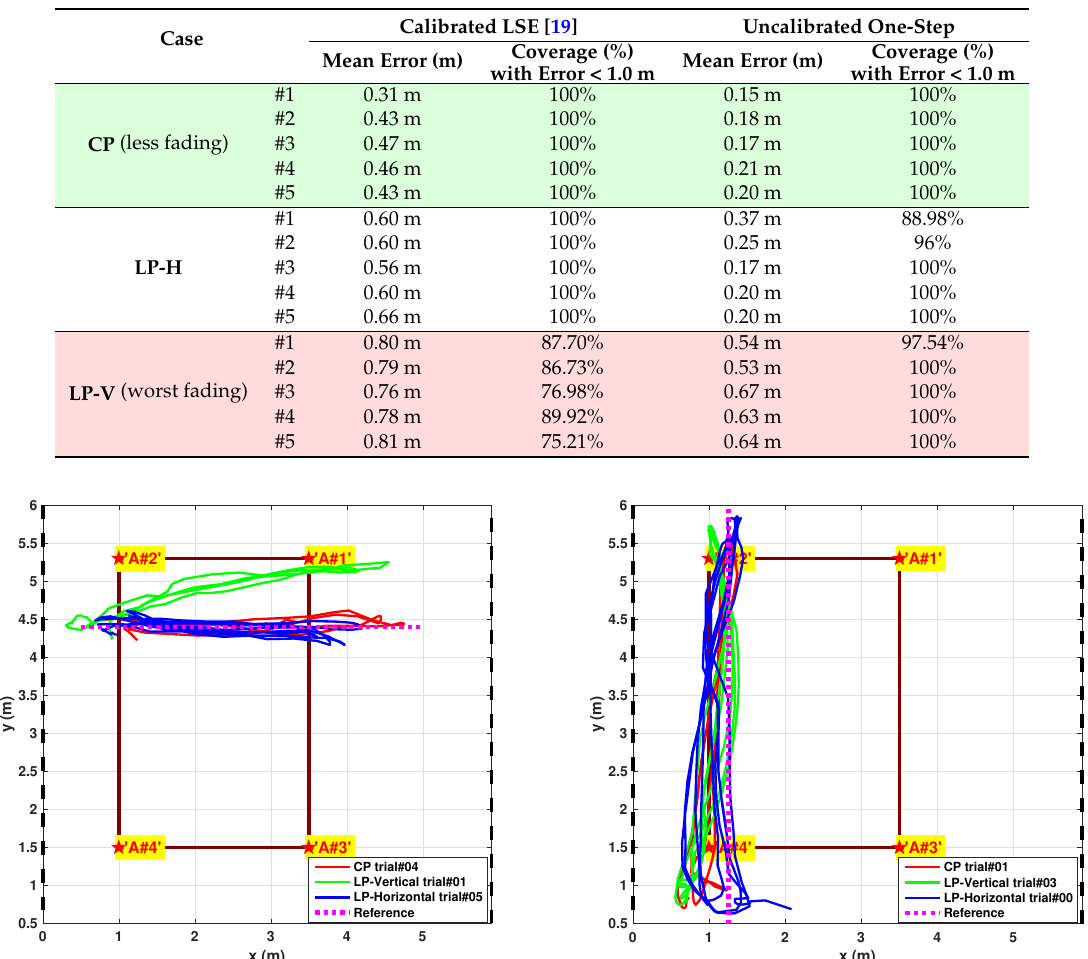
Table 5. Y-path Tracking estimation error results @ z REF = 1.10 m.